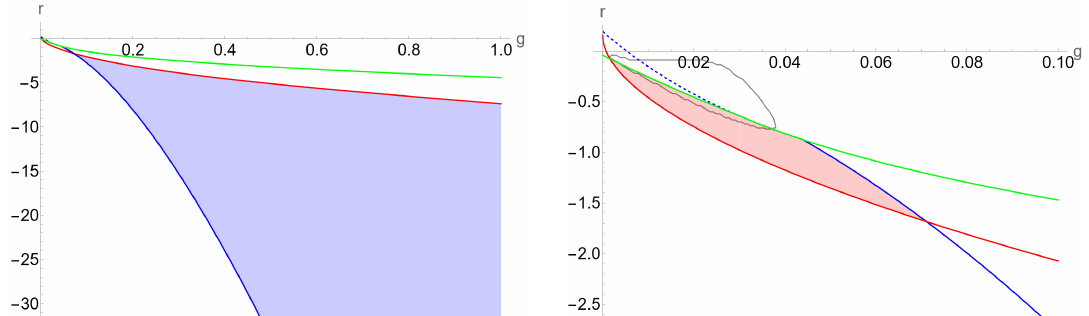
Figure 2 . The phase diagram of the multirace matrix model (5.1), with the right image zooming in on the vicinity of the origin of the parameter space. The three lines are boundaries of existence of the three types of solutions. The symmetric one-cut solution exists only above the green line, the symmetric two-cut solution exists only above the blue line and the asymmetric one-cut solution exists only below the red line. For the left image, in the region above the blue and below the red lines, where both two-cut and asymmetric one-cut solutions exist, the free energy of the two-cut solution is always smaller and thus this solution is preferred. See the text for the discussion of the situation in the right image. All lines in these images have been obtained numerically. The dashed blue line and the part of the green line to the right of the intersection with blue line agrees with (5.2).